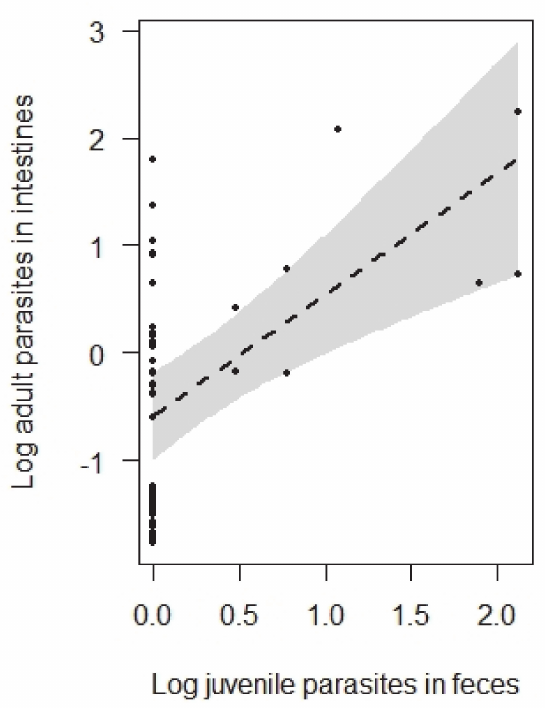
Figure 1. Relationship between log 10 juvenile (found in fecal samples) and log 10 adult (found in intestines) A. hamatospicula in frog hosts ( O. septentrionalis ). This plot is a conditional plot with fitted regression line (dotted line), partial residuals (dots), and a 95% confidence band (shaded) that controls for all factors in the statistical model that are not shown in the figure (frog snout-vent length and